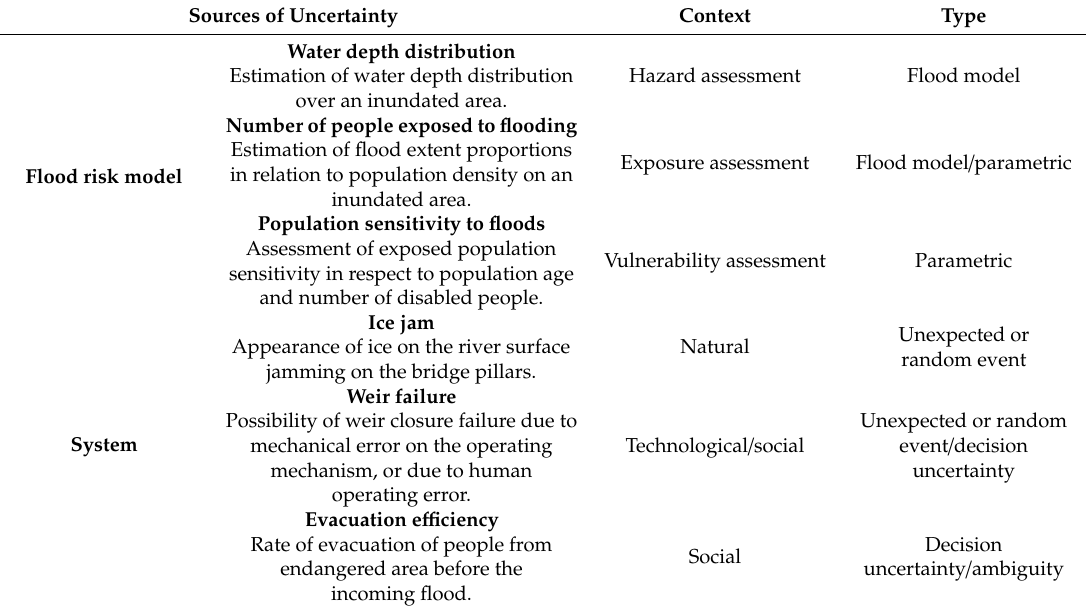
Table 3. Identified sources of uncertainty for the Slavonski Brod